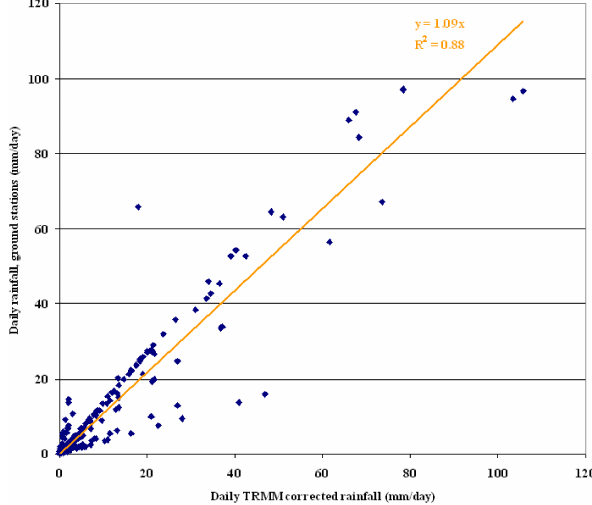
Fig. 6. Comparison of rainfall data from gauges and TRMM (TMPA-3B42R) corrected data, at daily scale, Puerto ila